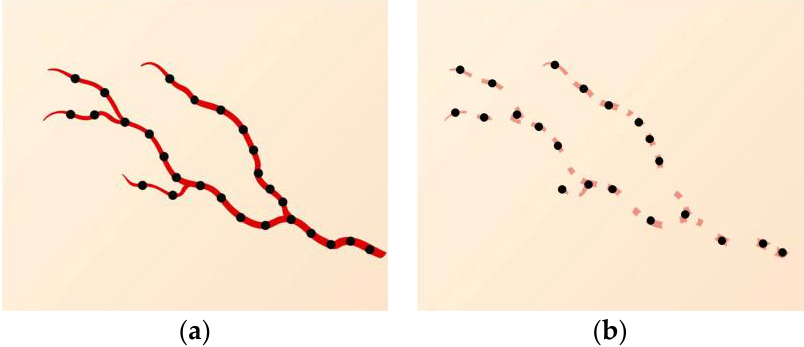
Figure 1. ( a ) Multiple black dots are the treated areas at telangiectasia. ( b ) The residual areas of the lesion are treated in the second session in the same manner.